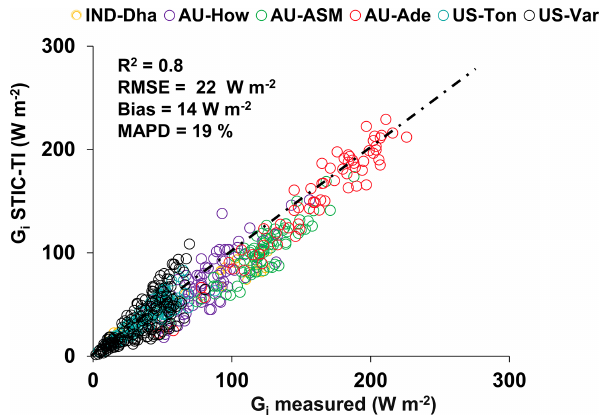
Figure 7. Validation of noontime (13:30) G i estimates with respect to in situ measurements in different ecosystems. The regression between the two sources of G i is G i (STIC-TI) = 0.90 G i (tower) − 0 .